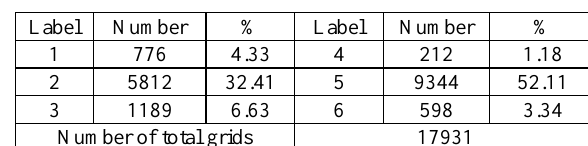
Table 3. The percentage of each label